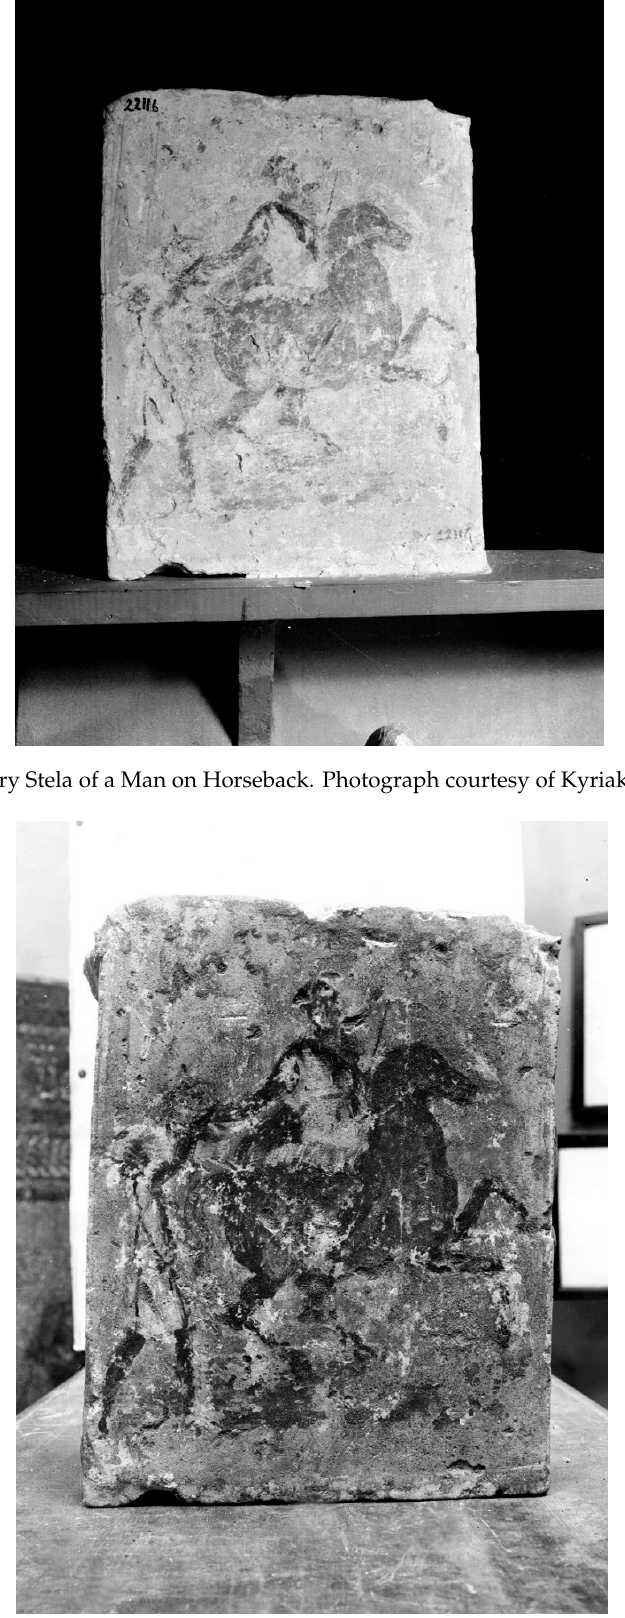
Figure 3. Funerary Stela of a Man on Horseback. Photograph courtesy of Kyriakos Savvopoulos.